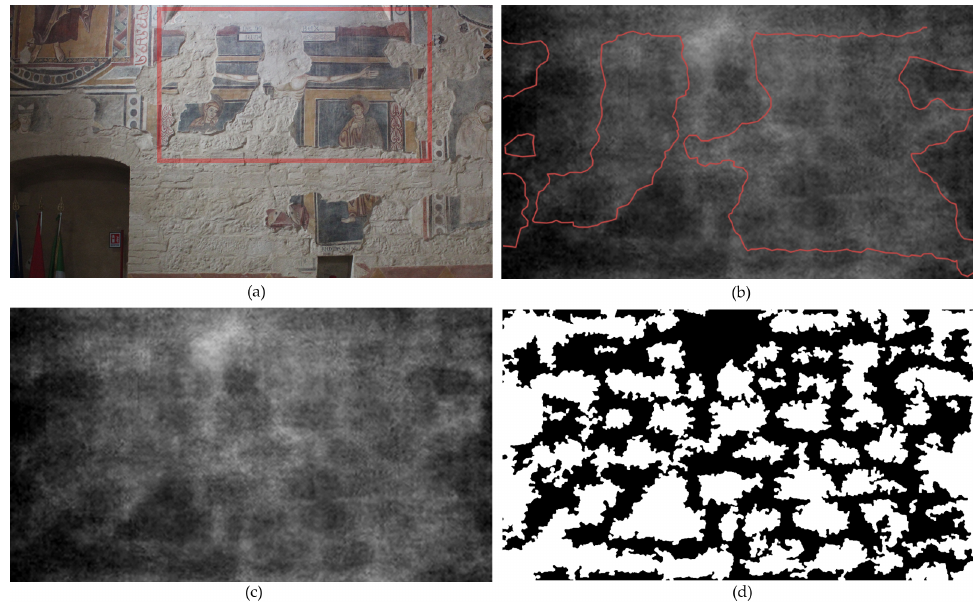
Figure 13. ( a ) Portion of the fresco under investigation, ( b ) thermal image where are highlighted in red the edges of what remains of the frescoes, ( c ) thermal image with improved contrast, ( d ) final binary image (see the cones of vision 7 and D in Figure